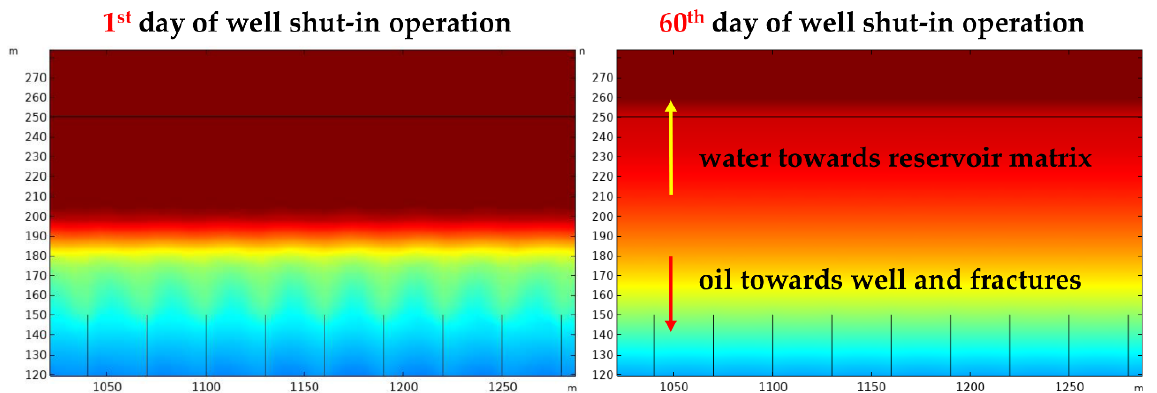
Figure 7. Magnified diagrams to compare oil saturation distribution. ( Left ): oil saturation at the beginning of shut-in; ( Right ): oil saturation after 60 days of shut-in.